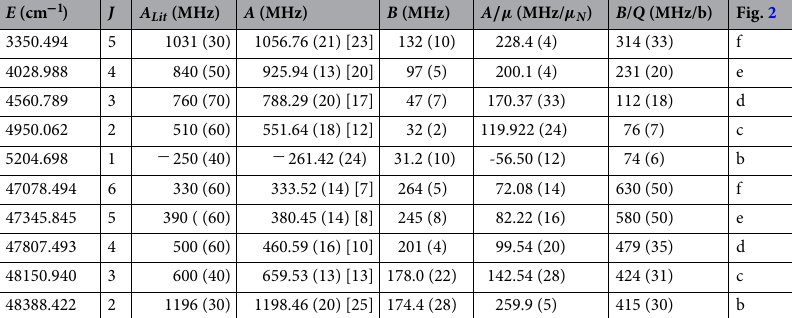
Table 1. Information on the energy levels and the measured hyperfine constants of 59 Co II ( I = 7/2). The A parameters are compared to literature 12 . Statistical uncertainties are reported in brackets and systematic uncertainties are reported in square brackets. In the sixth and seventh column the hyperfine field constants are reported. The last column indicates the figure of the measured spectrum in Fig.